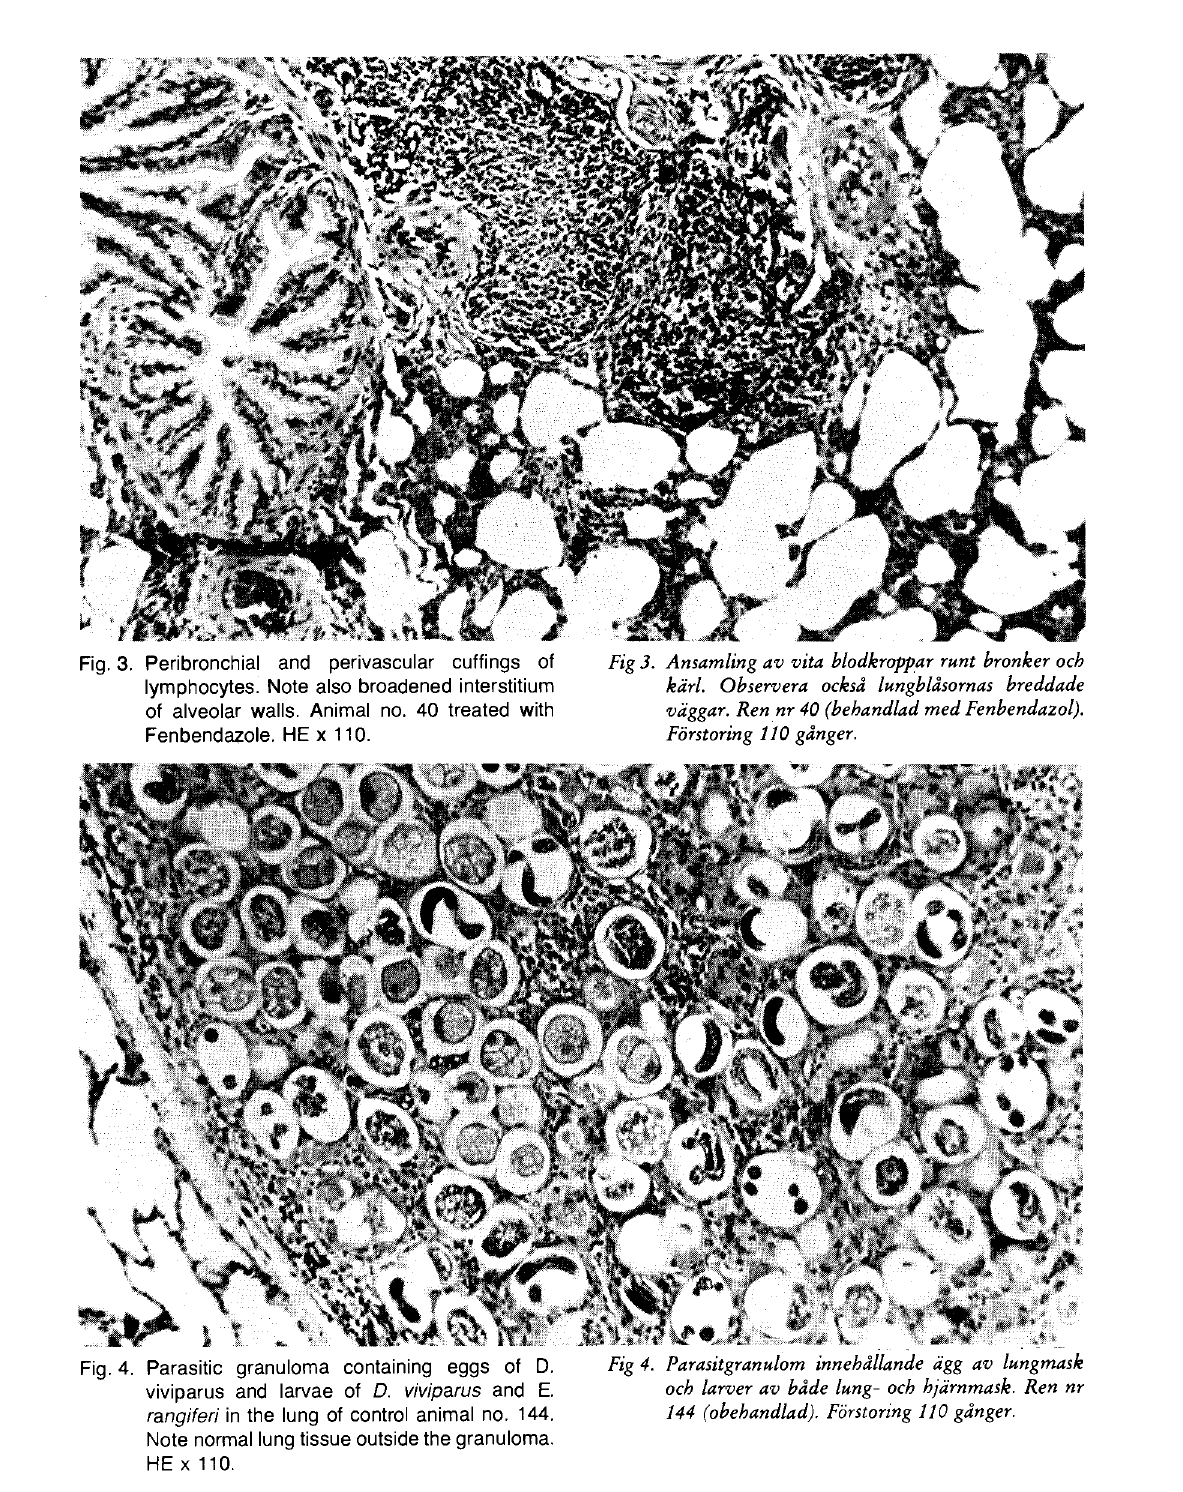
Fig. 4. Parasitic granuloma containing eggs of D. viviparus and larvae of D. viviparus and E. rangiferi in the lung of control animal no. 144. Note normal lung tissue outside the granuloma. HE x 110.